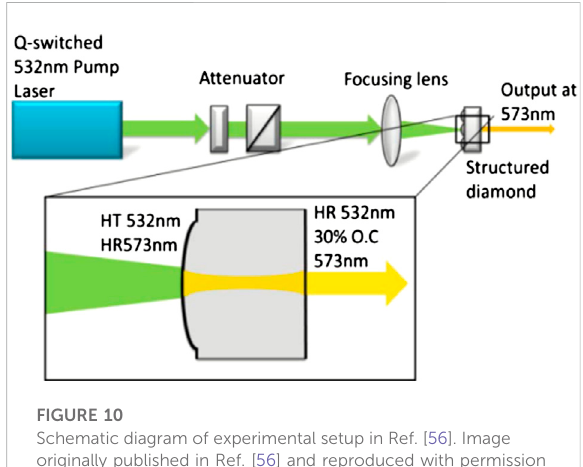
FIGURE 10 Schematic diagram of experimental setup in Ref. [56]. Image originally published in Ref. [56] and reproduced with permission from Optica Publishing group © The Optical